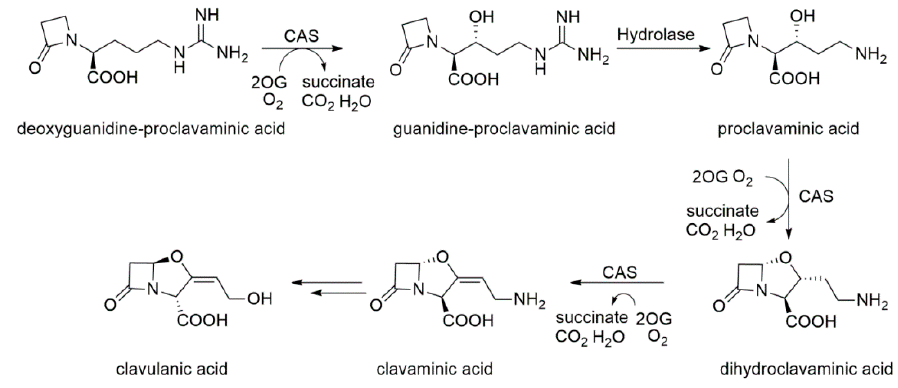
Figure 6. Biosynthesis of clavulanic acid. The tri-functional oxygenase CAS sequentially carries out a hydroxylation, ring formation, and desaturation step.